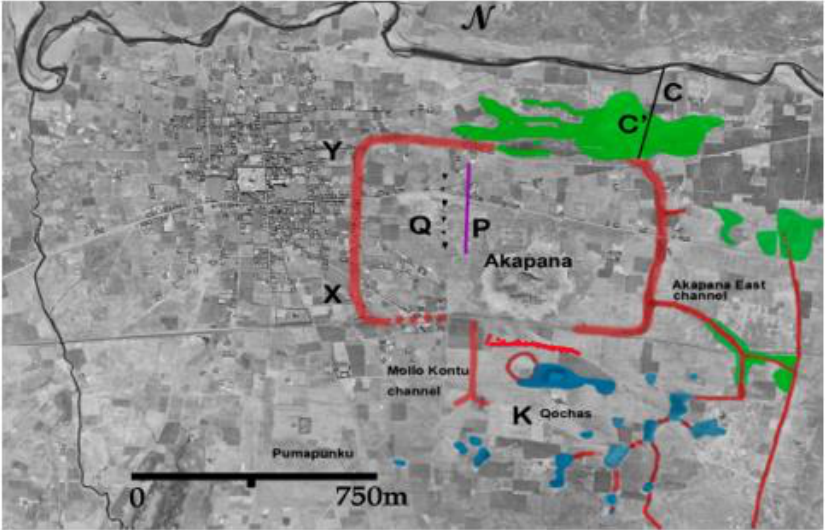
Figure 46. The recently discovered Mollo Kontu canal. Figures originally derived from 1940s aerial photos from Alan Sawyer at Tiwanaku and later annotated 2010 by John Janusek, Vanderbilt Uni- versity.